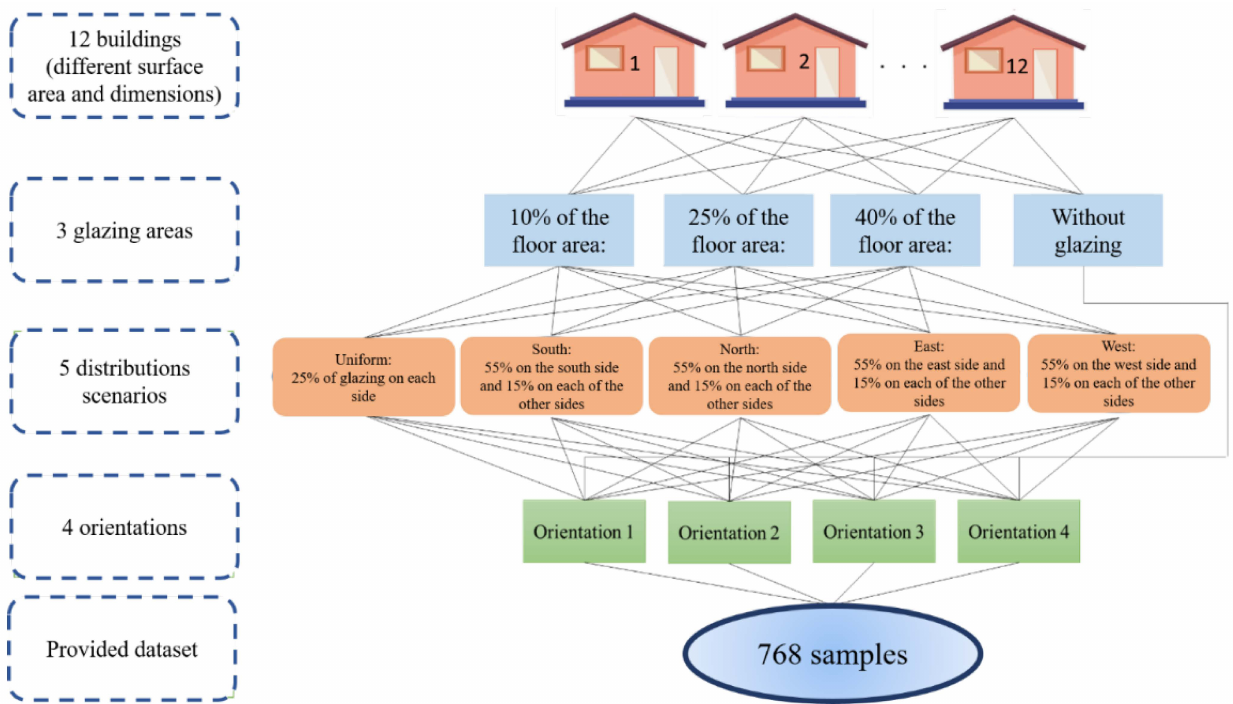
Figure 1. Graphical view of data